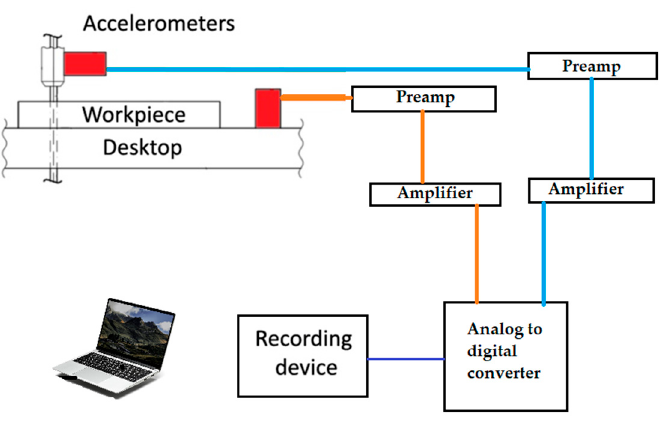
Figure 1. Equipment structure connection diagram.